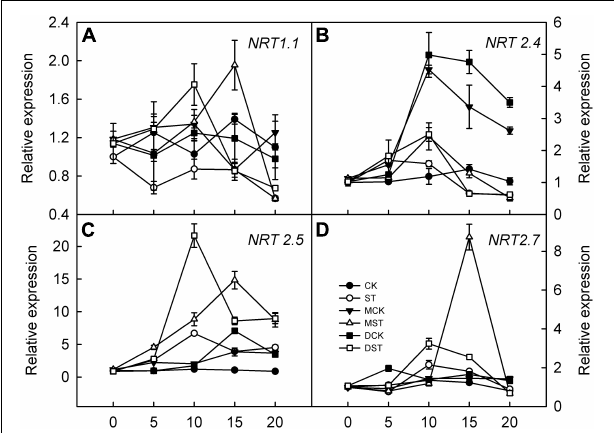
FIGURE 9 | Effects of melatonin and dopamine on expression of key genes involved in N-uptake in roots under different treatment conditions. (A) NRT1.1. (B) NRT2.4. (C) NRT2.5. (D) NRT2.7. Total RNA was isolated from samples at specified time points (0–20 days), converted to cDNA, and subjected to qRT-PCR. Data are means ± SD ( n = 3). CK, 2 mM K 15 NO 3 solution; ST, 0.1 mM K 15 NO 3 solution; MCK, 2 mM K 15 NO 3 solution with 0.1 µ mol/L melatonin; MST, 0.1 mM K 15 NO 3 solution with 0.1 µ mol/L melatonin; DCK, 2 mM K 15 NO 3 solution with 100 µ mol/L dopamine; DST, 0.1 mM K 15 NO 3 solution with 100 µ mol/L